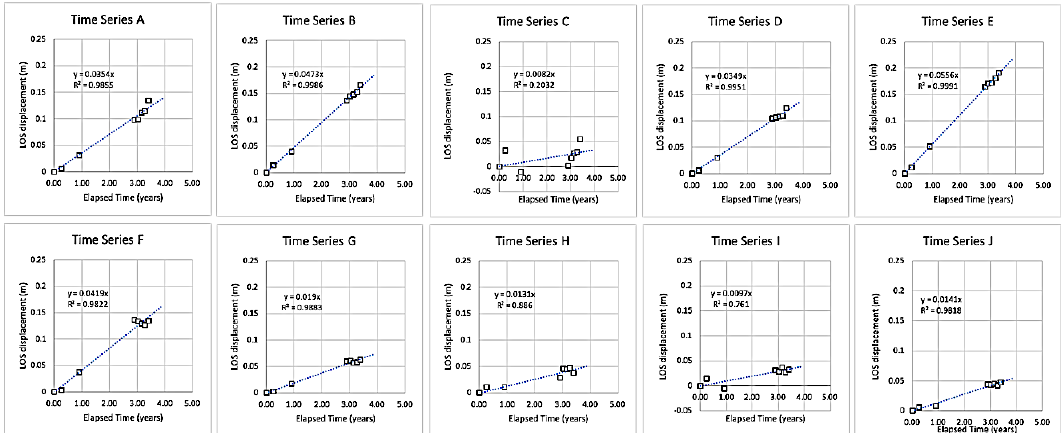
Figure 9. Selected time series of SBAS displacements with least square fit for velocity in m/year (modified from [51]).